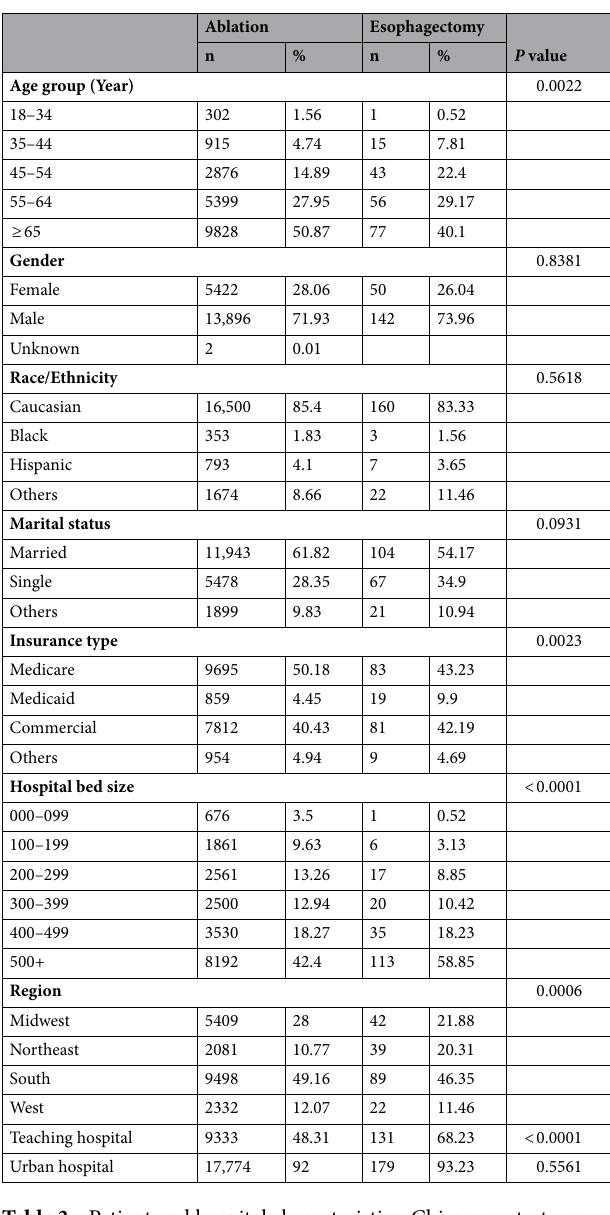
Table 3. Patient and hospital characteristics. Chi-square test was used to compare the difference between patients who had esophagus ablation and who had esophagectomy.8 patients who had ablation then had esophagectomy were grouped into esophagectomy